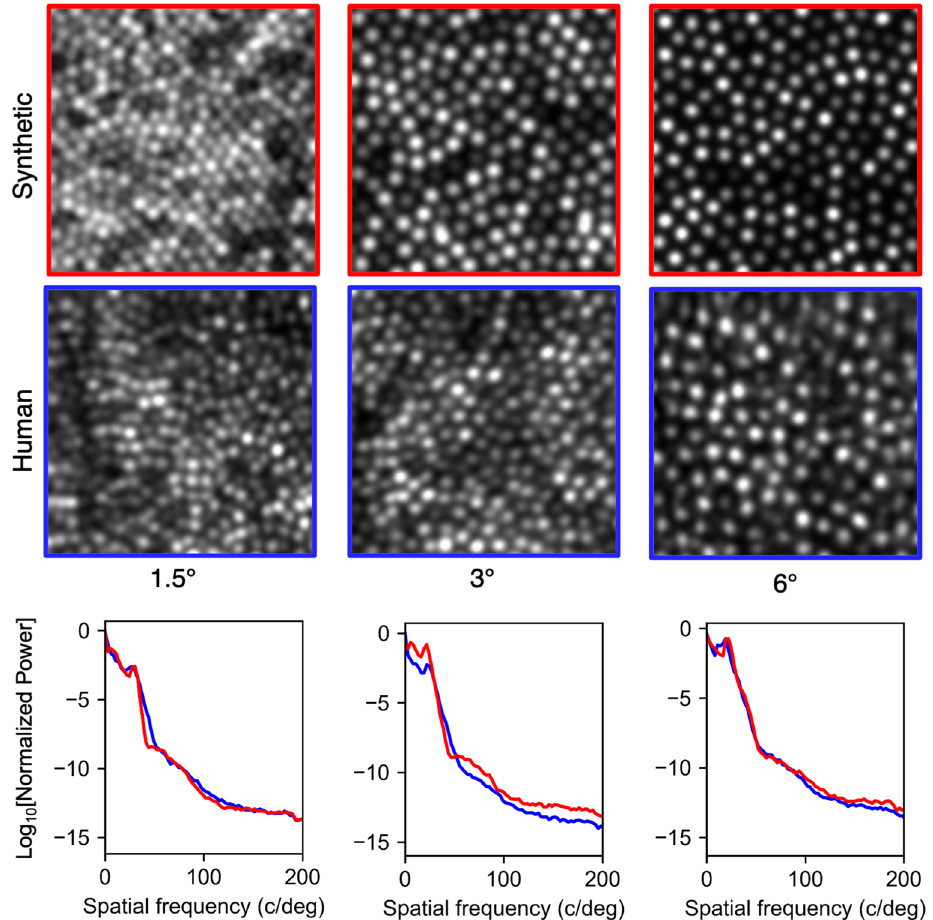
Figure 6. Example images from a human participant collected from our AOSLO 72 and synthetic images generated for the same eccentricities— 1.5 ◦ , 3 ◦ and 6 ◦ . The synthetic images are generated with no noise, residual aberration or eye motion and so have better image quality than the human images. The pupil diameter for the simulation was set to 5 mm, which is approximately the same as the diameter of the human participant’s pupil during image capture. The synthetic images were spatially scaled to account for the human participant’s axial length being different to that of the model. The synthetic images presented here have been intensity-scaled linearly and then clipped such that the number of pixels that are saturated is the same as in the human images (approximately 10% for the detector gain that was used during imaging). The lower panels show the power spectra of the synthetic images in red and the human images in blue. In each spectrum, the peak below 50 c/deg corresponds to the modal spacing of the cones (Yellot’s